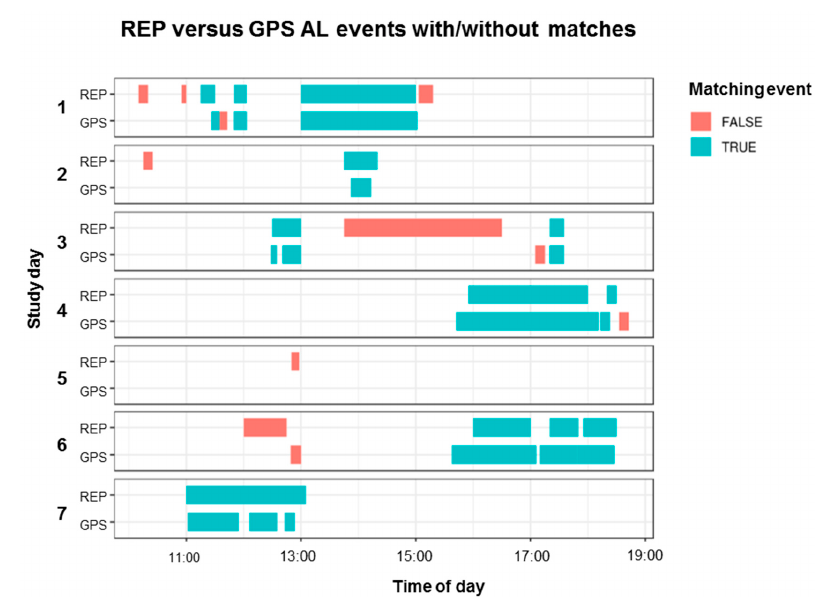
Figure A2. Identification of matched events exemplified by one week of self-reported (REP) and GPS-